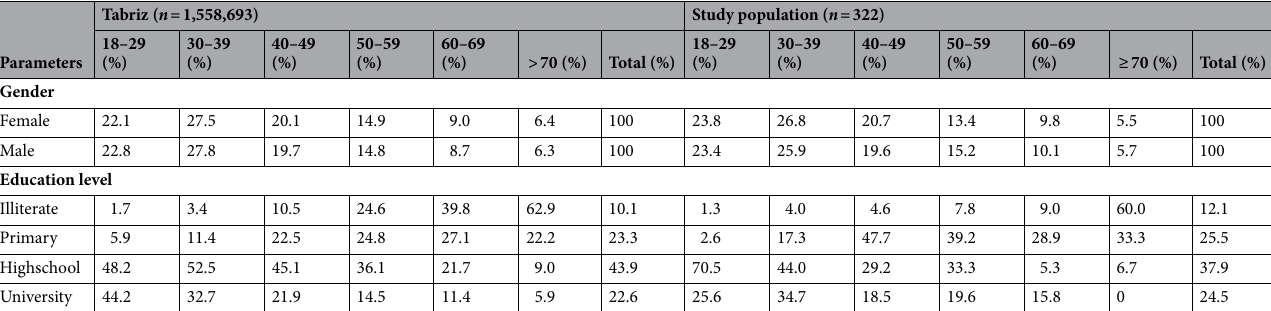
Table 3. After applying the Bonferroni correction, cold intolerance was significantly more common in females and people with comorbidities (Table 3).